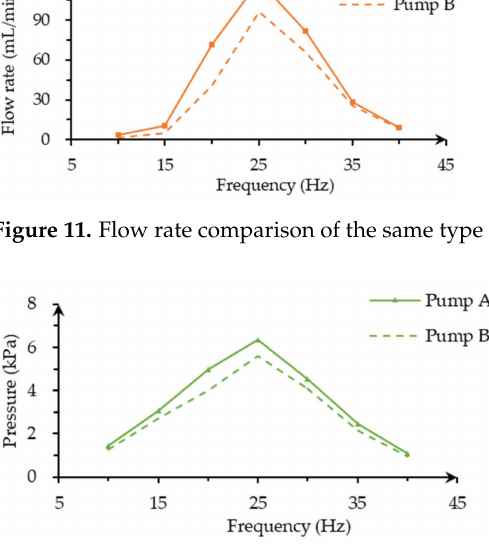
Figure 12. Output pressure comparison of the same type of